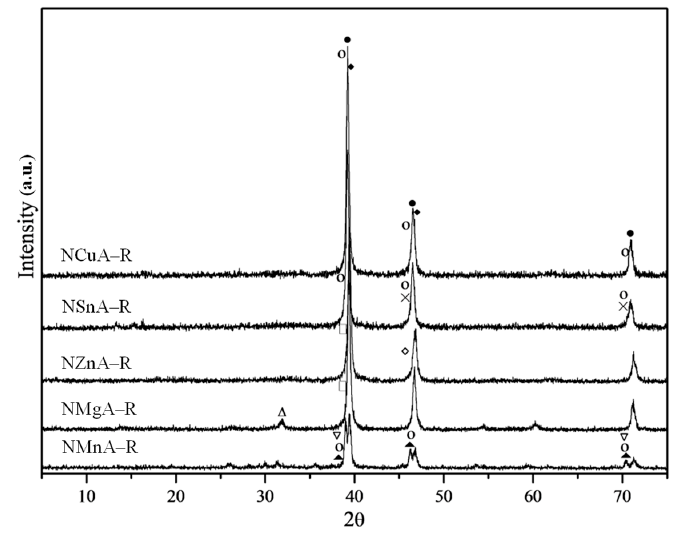
Figure 3. XRD patterns of di ff erent hydrotalcite-derived catalysts after reduction. (cid:8) :